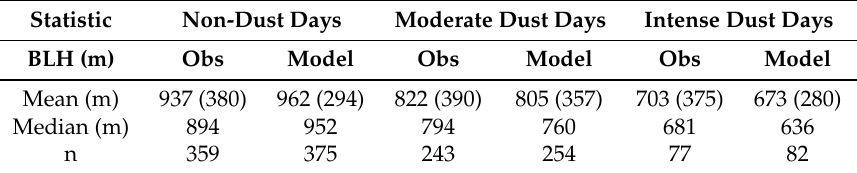
Figure 5. Box plot of marine boundary layer height (BLH) from radiosonde observations and ECMWF IFS numerical weather prediction model for ( a ) winter dust outbreaks (Dec–Mar) and ( b ) summer dust outbreaks (Jul–Aug) calculated for all days, non-dust outbreak days, and different intensities of dust outbreaks (2012 to 2017): The horizontal lines and the squares within the box represent the median and mean values, respectively, while the bottom and top of each box are the 25th and 75th percentiles. The whiskers are the 5th and 95th percentiles. Table 1. Statistical metrics for marine boundary layer height (BLH) from radiosonde observations (Obs) and the IFS model during non-dust outbreak days and for different intensities of dust outbreaks in the Canary Islands for the winter season (December–March), 2012–2017: Standard deviation in the mean is given in parentheses.